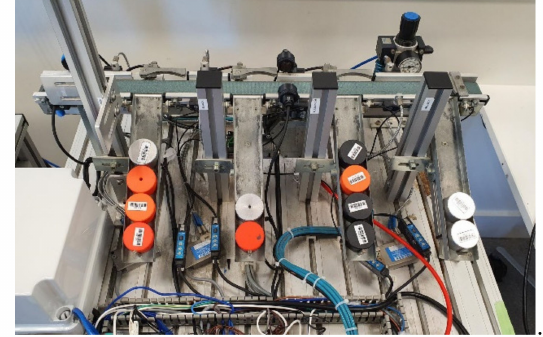
Figure 4. Experiment 2 Festo sorting machine.